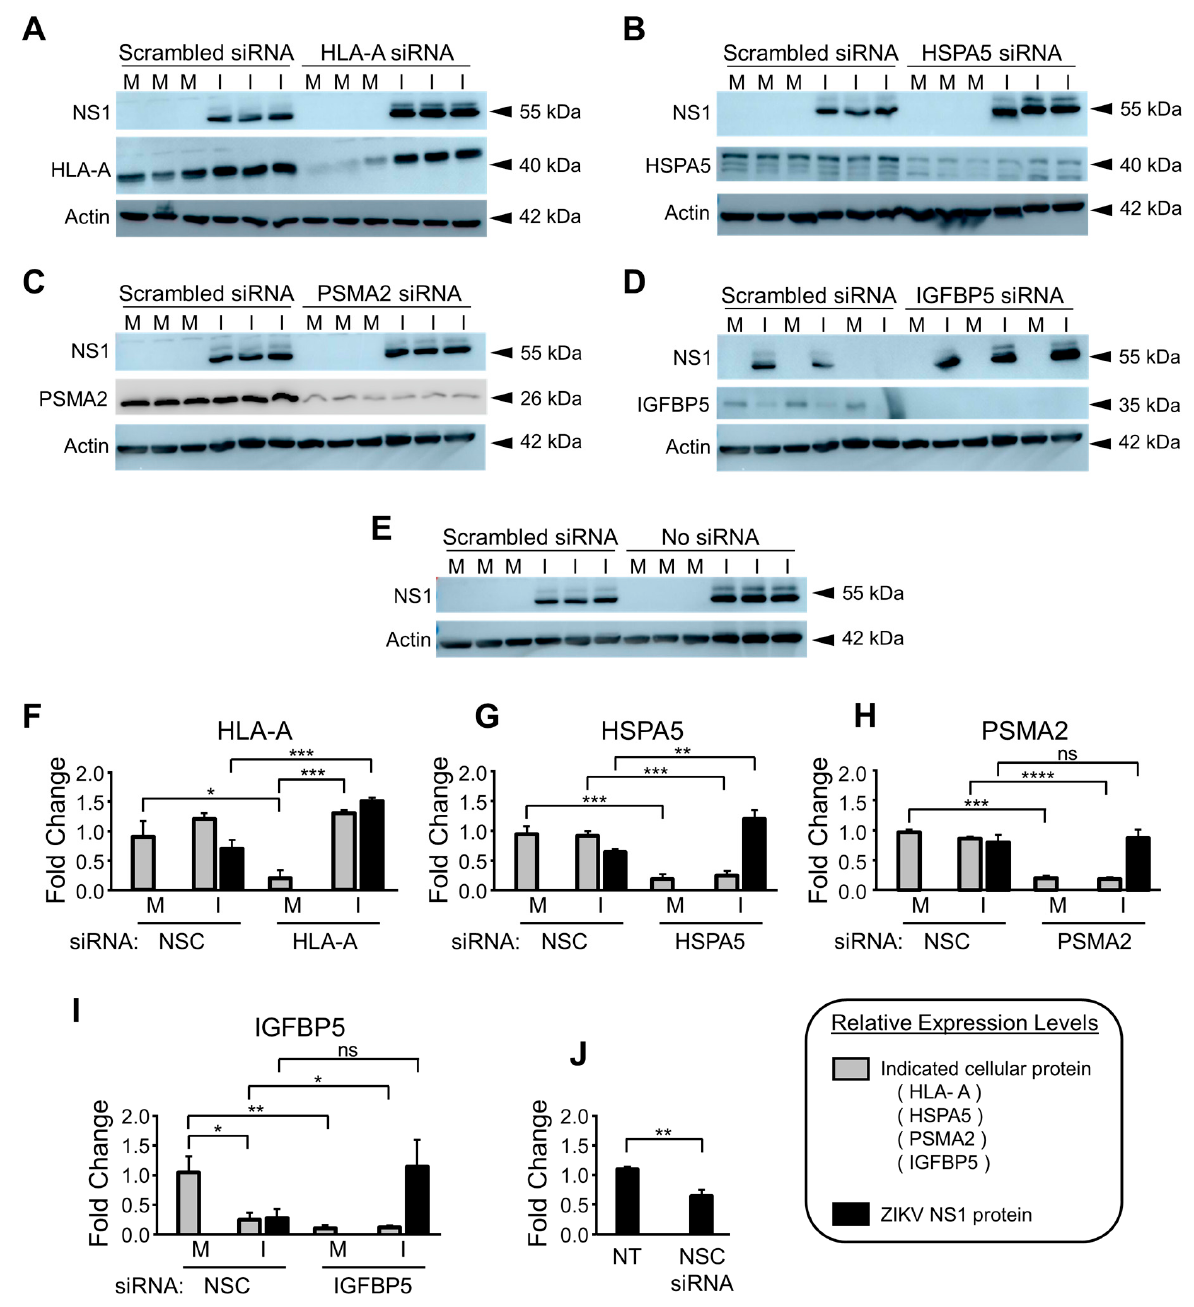
Figure 9. Effect of siRNA treatment on ZIKV NS1 expression in U251 cells at 48 hpi ( A ), NS1 and HLA-A protein expression in scrambled non-silencing siRNA vs. HLA-A siRNA-treated mock (M) and ZIKV-infected (I) U251 cells. ( B ), NS1 and HSPA5 protein expression in scrambled siRNA and HSPA5 siRNA-treated mock vs. ZIKV-infected U251 cells. ( C ), NS1 and PSMA2 protein expression in scrambled siRNA and PSMA2 siRNA-treated mock vs. ZIKV-infected U251 cells. ( D ), NS1 and IGFBP5 protein expression in scrambled siRNA and IGFBP5 siRNA-treated mock vs. ZIKV-infected U251 cells. ( E ), NS1 protein expression in scrambled siRNA and non-treated (no siRNA) mock vs. ZIKV-infected U251 cells. ( F – J ) show the protein quantifications of each of the bands for siRNA targeted proteins and ZIKV NS1 protein shown in ( A – E ), respectively. Errors bars represent standard deviation and 2-tailed Students t -test was used for statistical significance and to obtain p -values. * p -value < 0.05, ** p -value < 0.01, *** p -value < 0.001, **** p -value < 0.0001. M: mock; I: infected.